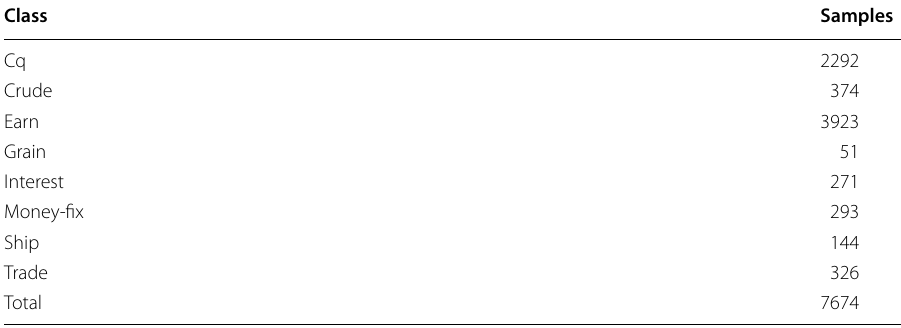
Table 2 Splitting of documents among eight classes in Reuters‑R8 dataset